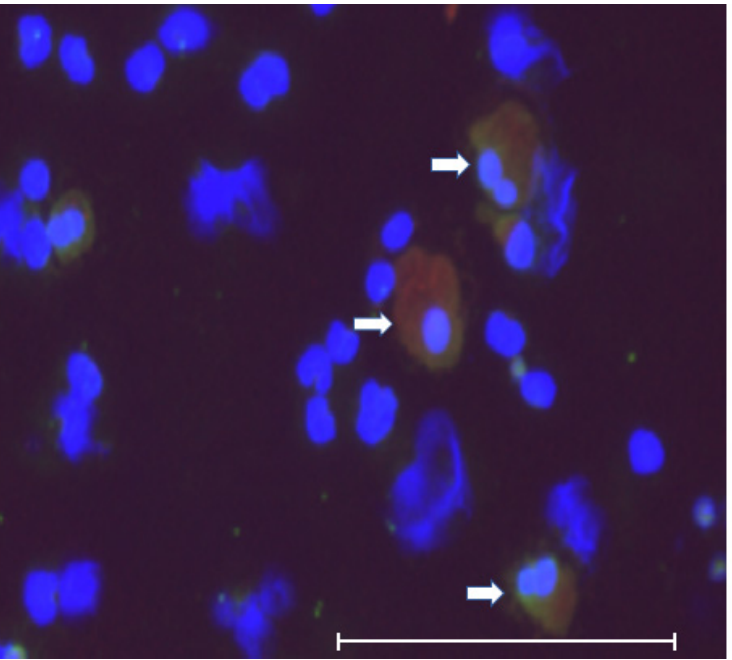
Figure 4. Morphology of double positive cells. These cells were large, polymorphic, and polynuclear, which suggested that they were tumor–macrophage fusion cells (TMFs), macrophage–tumor cell fusion cells (MTFs), or cancer-associated macrophage-like (CAMLs) cells. The scale bar shows 150 µ m. White arrows indicate CK/CD45 double positive cells